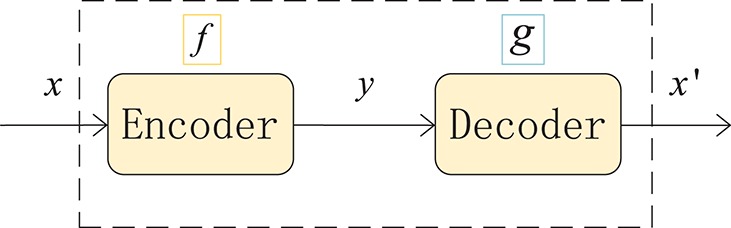
Structure of an autoencoder. The network consists of two parts: an encoder represented by the function f and a decoder, g. The encoder compresses the input into a hidden layer representation, and the decoder reconstructs the input from the hidden layer.